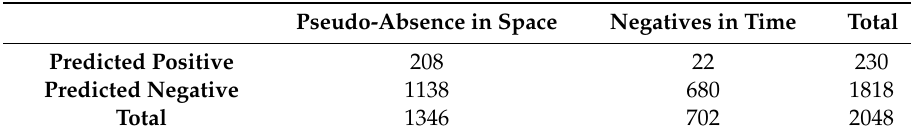
Table 5. Observed negatives grouped by typology of negatives: pseudo-absence in space and negatives in time (i.e., mosquitoes collections) .